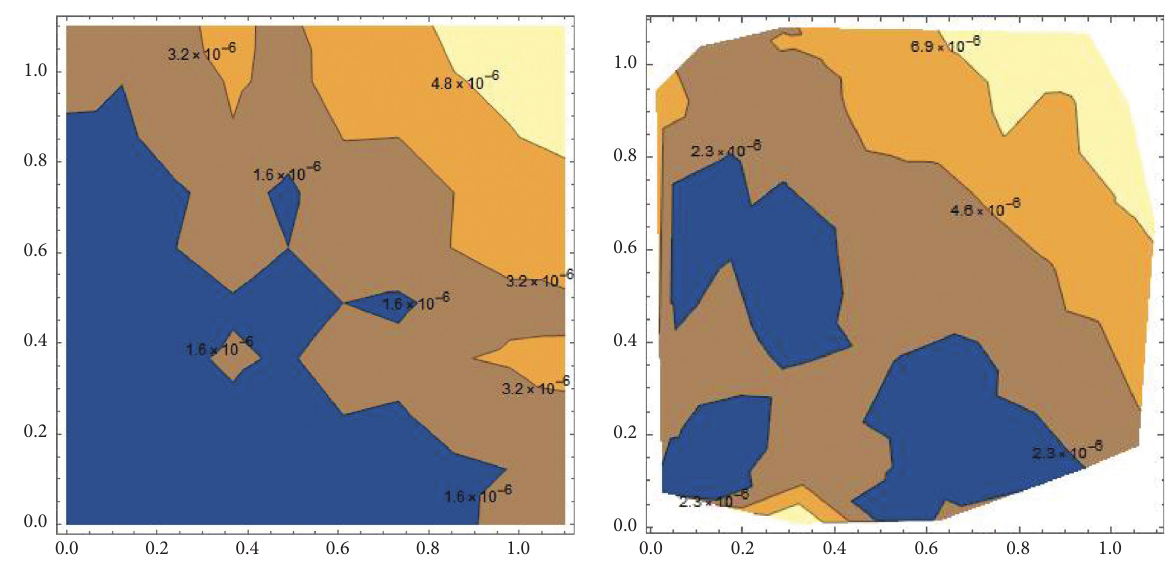
Figure 8: Contour plot errors for the same